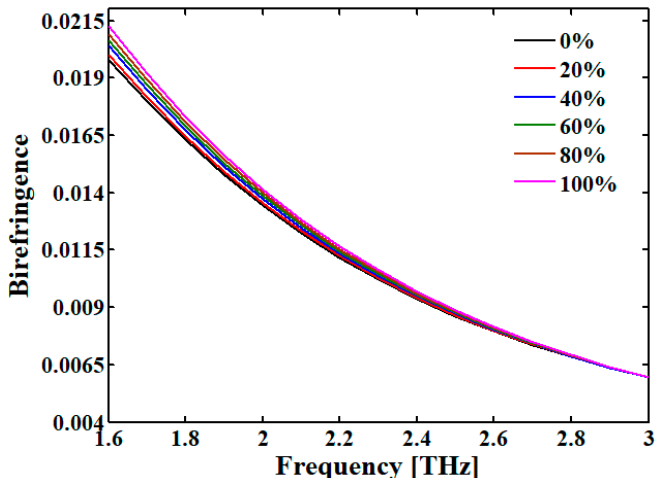
Figure 8. Birefringence of the proposed fiber as a function of core length at f = 2.8 THz for different adulteration of petrol oil with kerosene. Fibers 2020 , 8 , x FOR PEER REVIEW